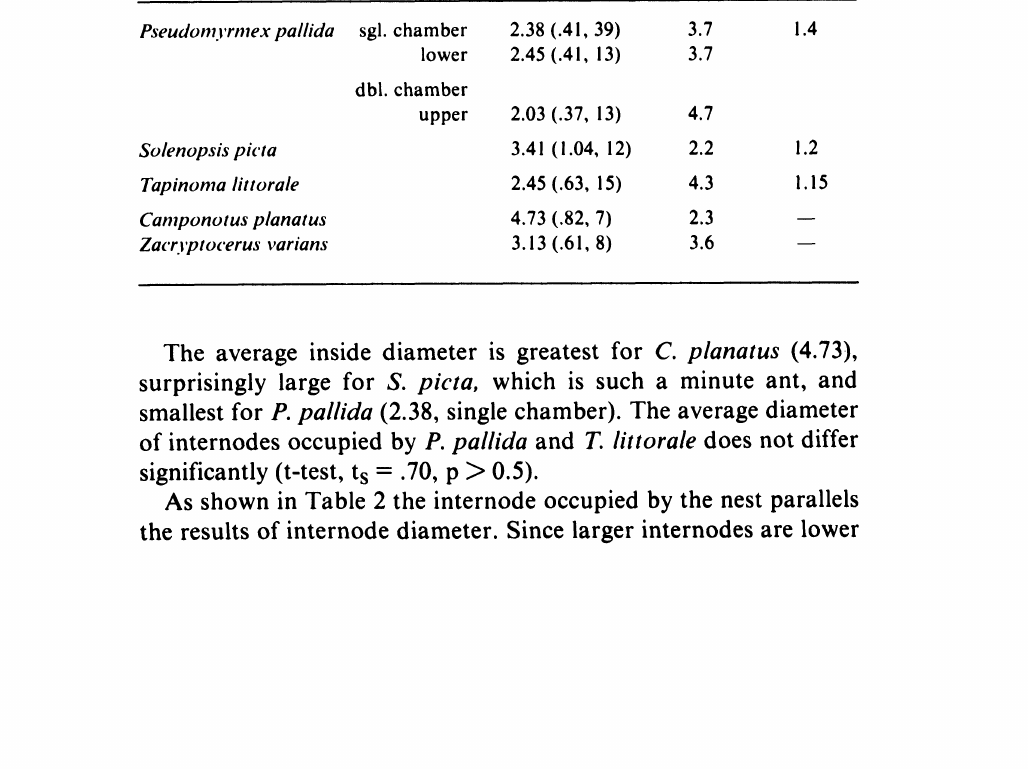
Table 2. Nest Characteristics of Sawgrass